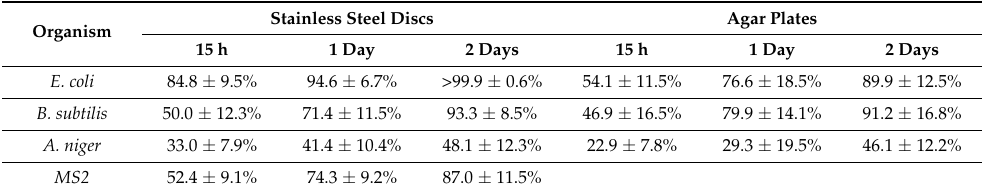
Table 1. Mean reductions of microorganisms on stainless steel and agar surface when exposed to the oil mixture vapour in the small enclosure compared with controls that had not been exposed (deviations represent STD of at least three measurements).